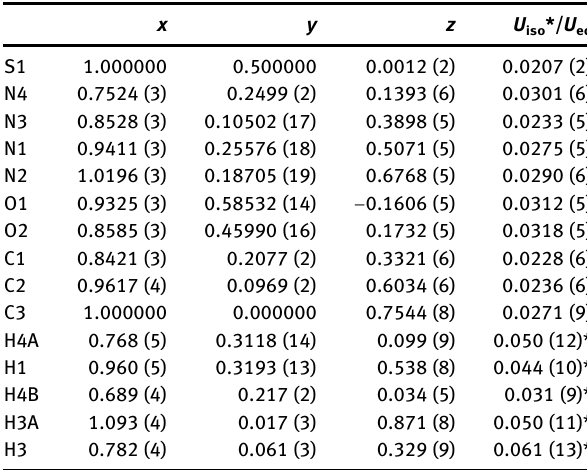
Table  : Fractional atomic coordinates and isotropic or equivalent isotropic displacement parameters (Å 